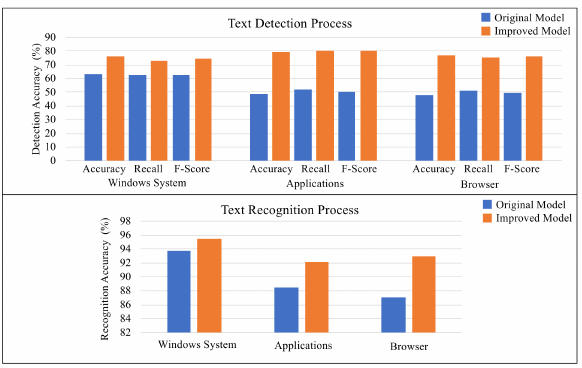
Figure 9. The accuracy of the original model and the improved model.